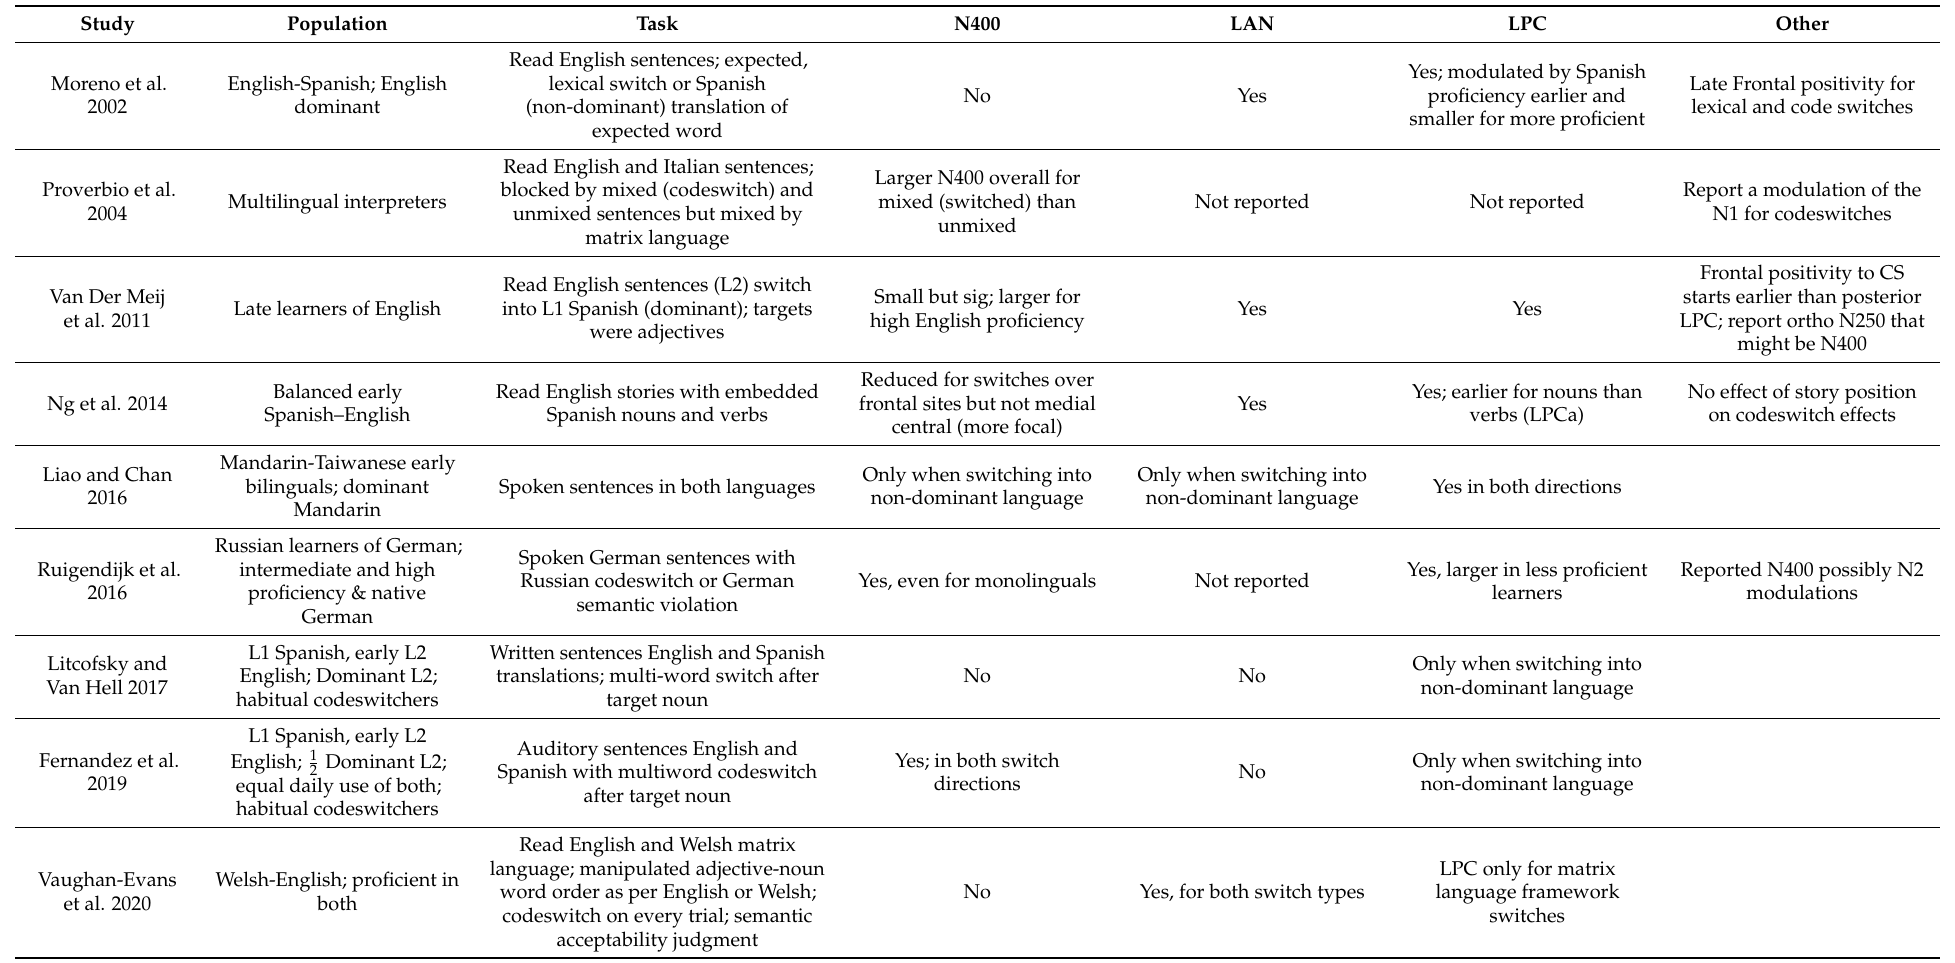
Table 1. Summary of studies to date measuring ERPs to codeswitches during sentence comprehension. Key population and task factors are noted, including switching habits where reported, direction of switch where appropriate and format of sentences (written or auditory). Effects on N400, LAN and LPC